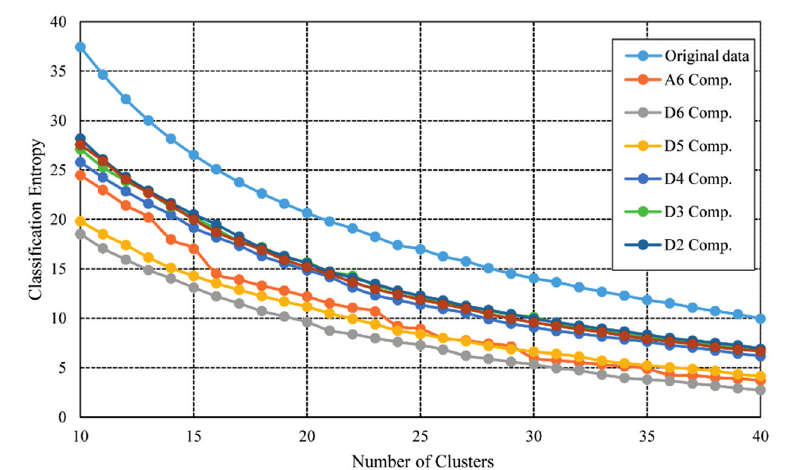
Figure 6. Determination of Cluster